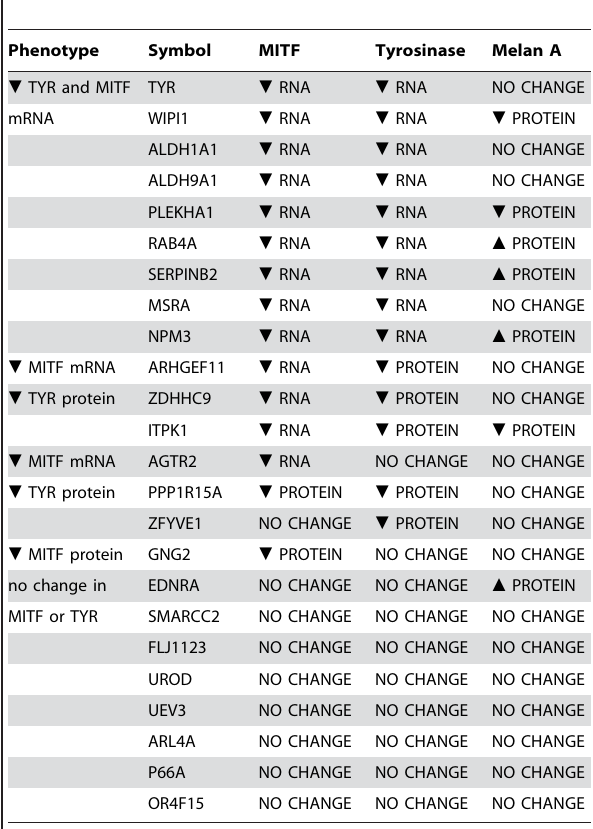
Table 2. Genome-Wide siRNA Screening Identifies Targets That Differentially Impact Tyrosinase and MITF